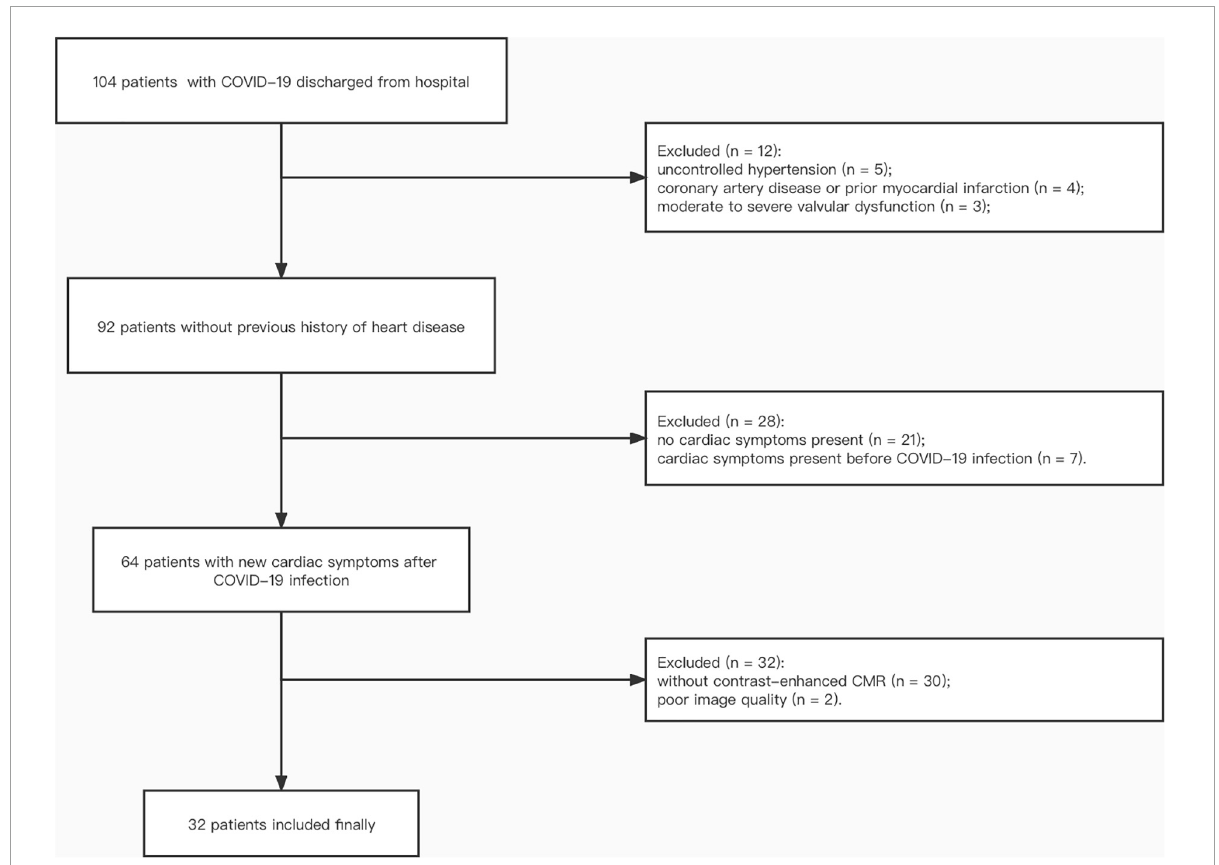
FIGURE1 Participant flow diagram. COVID-19, coronavirus disease 2019; CMR, cardiac magnetic resonance.